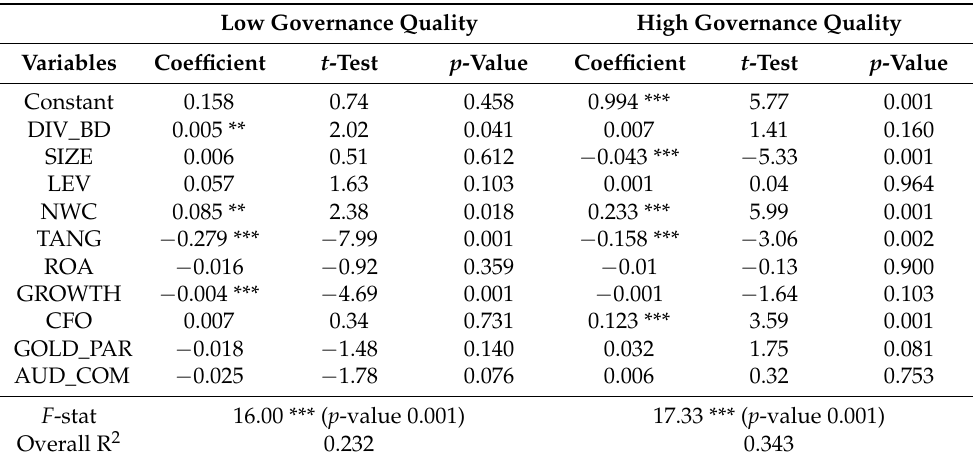
Table 6. Fixed-effect regression results of the main model based on the quality of corporate gover-